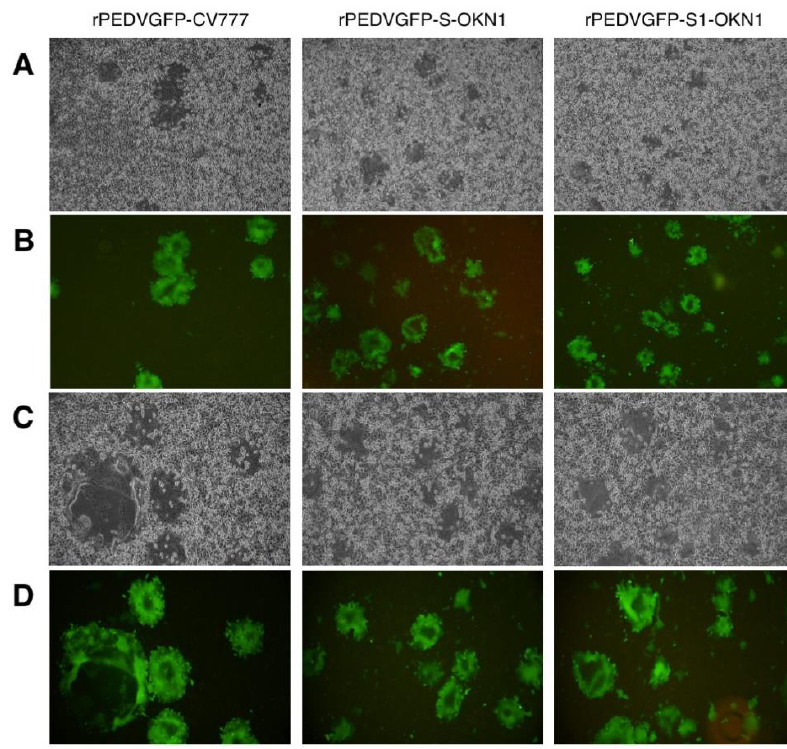
Figure 3. Cytopathic effects ( A , C ) and GFP expressions ( B , D ) by a microscopic observation of recombinant PEDVs, rPEDVGFP-CV777, rPEDVGFP-S-OKN1, and rPEDVGFP-S1-OKN1 isolated from feces collected at peak virus shedding. ( A , B ): Magnification, 40 × , ( C , D ): magnification, 100 × .